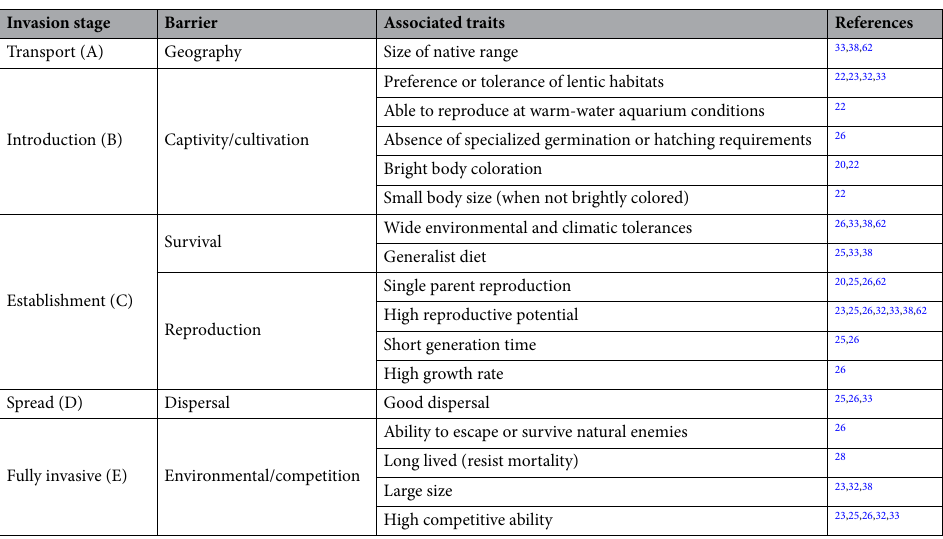
Table 1. Invasion framework by Blackburn et al . 24 with functional traits mentioned in literature as relevant to the barriers of each